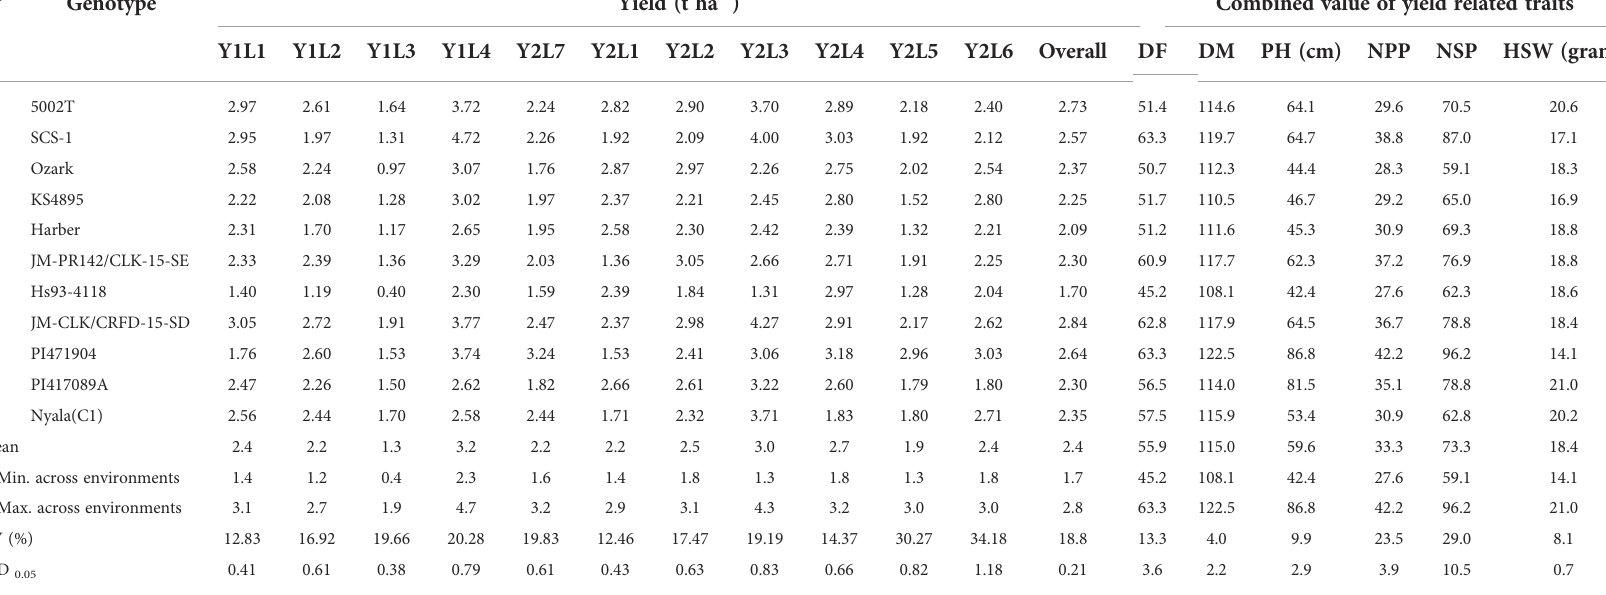
TABLE 4 Mean performance days to fl owering, days to maturity, plant height, number of pods per plant and, number of seeds per, branch per plant early maturing across years and environments in 2018 and